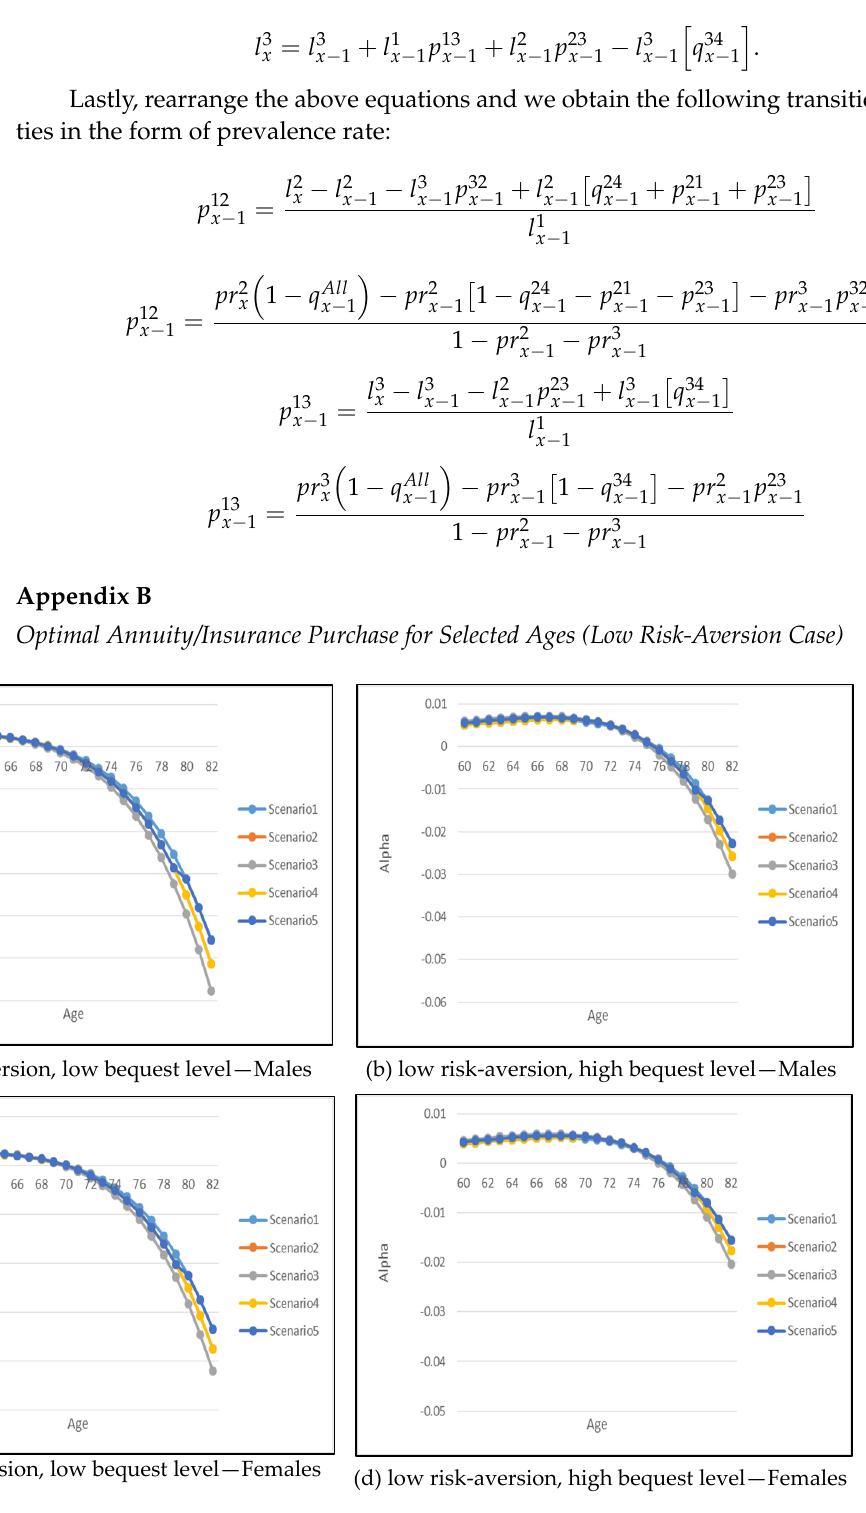
Figure A1. Optimal Annuity/Insurance Purchase for Selected Ages (Health-Independent Utility).